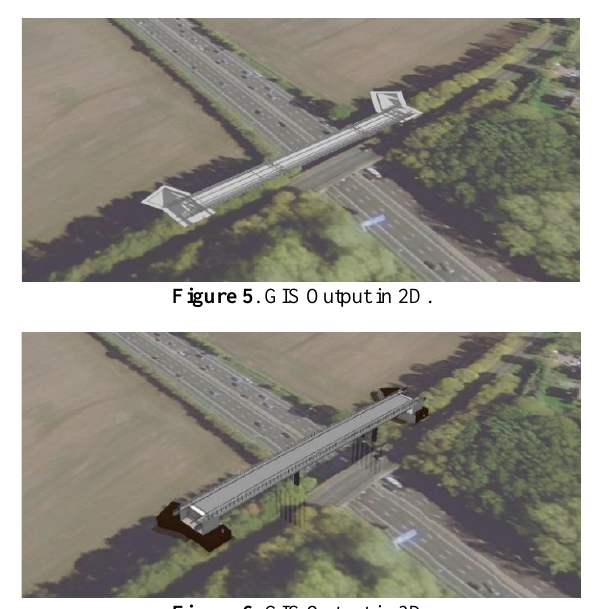
Figure 6 . GIS Output in 3D.